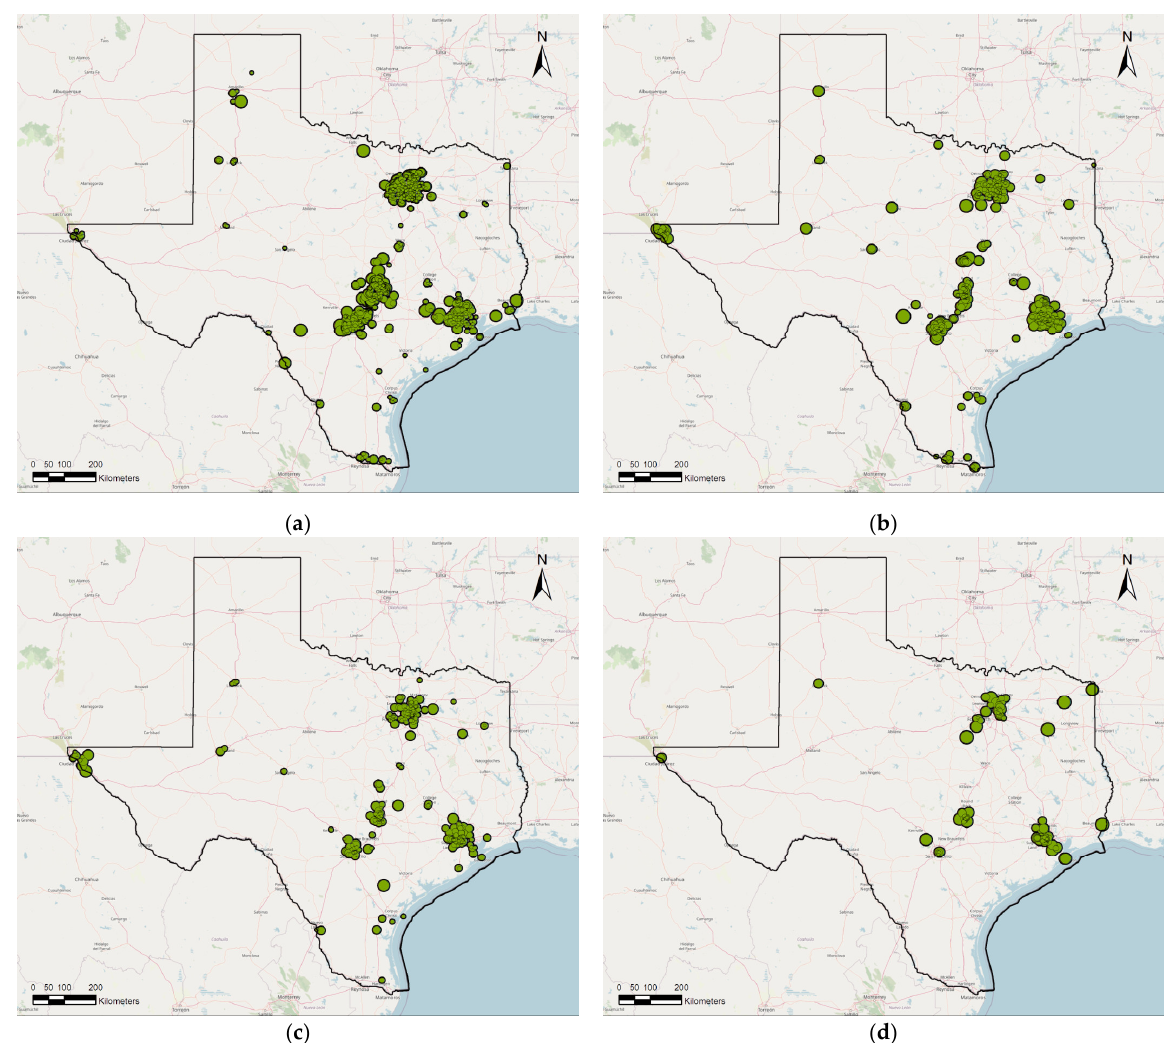
Figure 10. Accessibility of green spaces for different green building certification levels by visualiza- tion: ( a ) Certified, ( b ) Silver, ( c ) Gold, and ( d ) Platinum.